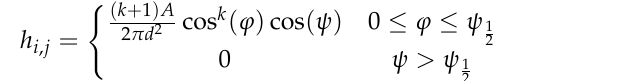
the channel gain. Light of sight (LOS) paths can be modeled with a generalized Lambertian radiant intensity [21]. In general, the energy of the reflected light can be omitted compared with the LOS light, and the system performance mainly depends on the optical signals